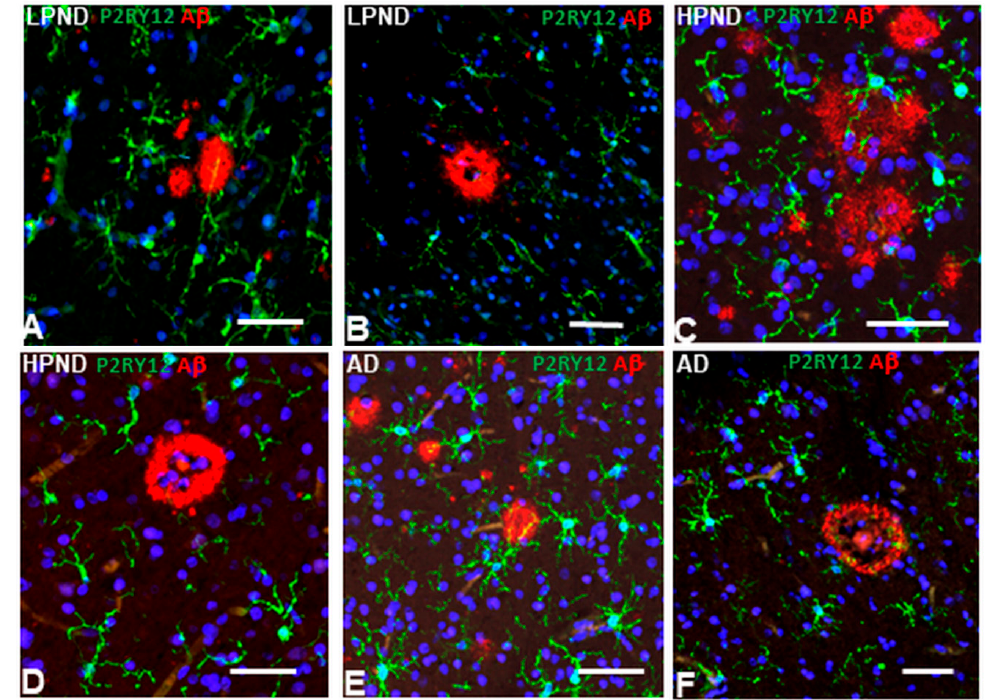
Figure 9. Interaction of P2RY12-positive microglia with different types of A β -positive plaques in pathologically-staged cases. ( A – F ). P2RY12-positive microglia (green) interacting with A β -positive diffuse-type plaques (red) ( A , C , E ), in LPND ( A ), HPND ( C ), and AD ( E ), but not with mature-type cored plaques ( B -LPND) ( D -HPND) ( F -AD). Scale bars represent 50 μ m.